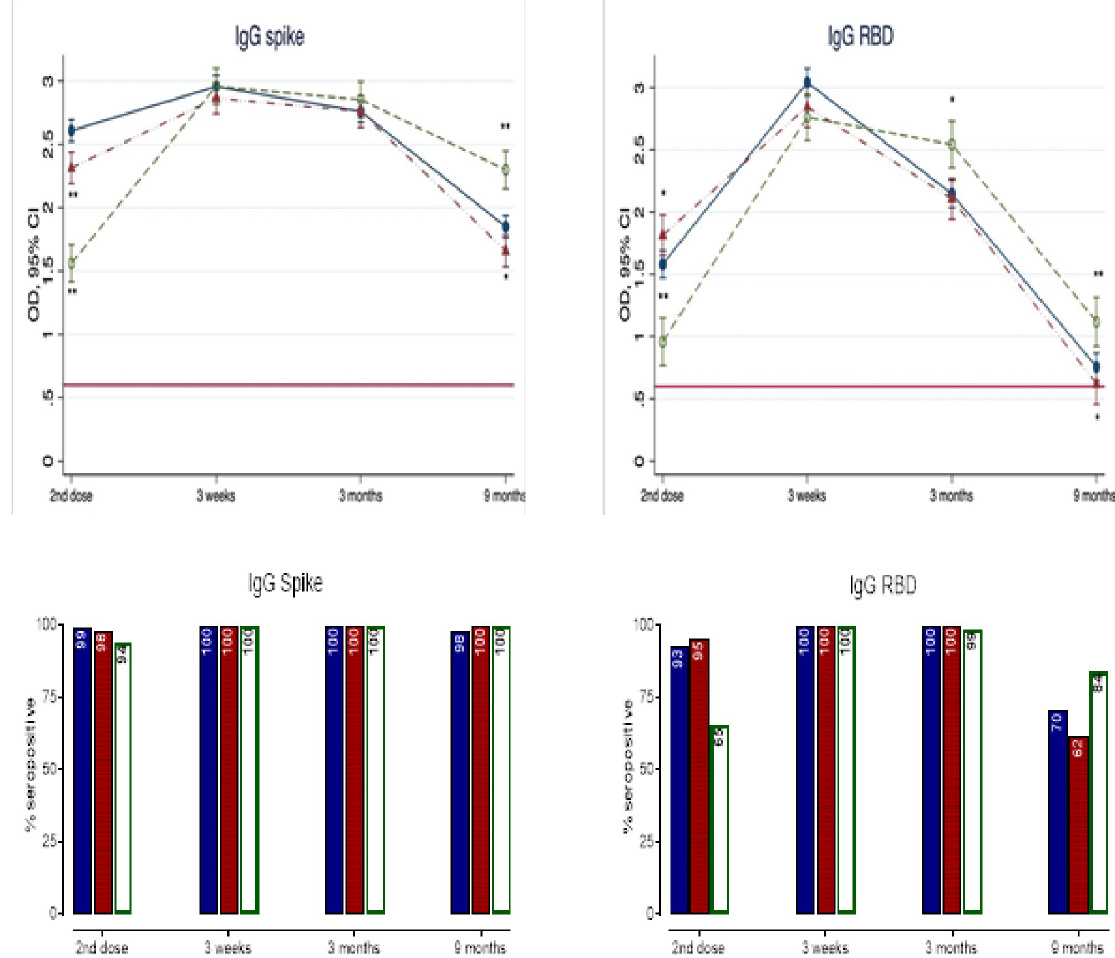
Fig 2. Mean titers and seropositivity rates for IgG to ancestral SARS-CoV-2 Spike and RBD by study visit and dosing interval. Upper panel: Serum IgG titers to ancestral SARS-CoV-2 Spike and RBD measured in each group at the same time point post-2 nd dose using a validated ELISA (see METHODS). Data are expressed in optical density (OD) with 95% confidence interval (CI) and fully adjusted for age, sex, education, smoking, alcohol use, body-mass index, known comorbidities (cardiovascular, neoplastic, autoimmune, renal and chronic respiratory diseases) and the number of days after 2 nd vaccine dose to subsequent blood draw. The dosing interval groups 35-42-days (red symbols) and > 42-days (open green symbols), were compared to the < 35-days group (reference, blue closed symbols). For the summary numerical data, please refer to S3 Appendix in S1 File. Interaction terms for visit x group were all significant at p < 0.0001. Therefore, between group comparisons ( < 35-day group as reference) were conducted with p-values � < 0.05 and �� < 0.005. The red solid line represents the assay’s threshold of detection (see S1Appendix in S1 File for numerical values). Lower Panel: The bars represent the % of participants with seropositive IgG to ancestral SARS-CoV-2 Spike and RBD within each group by visit. Seropositivity was defined by titer levels above the assay’s threshold of